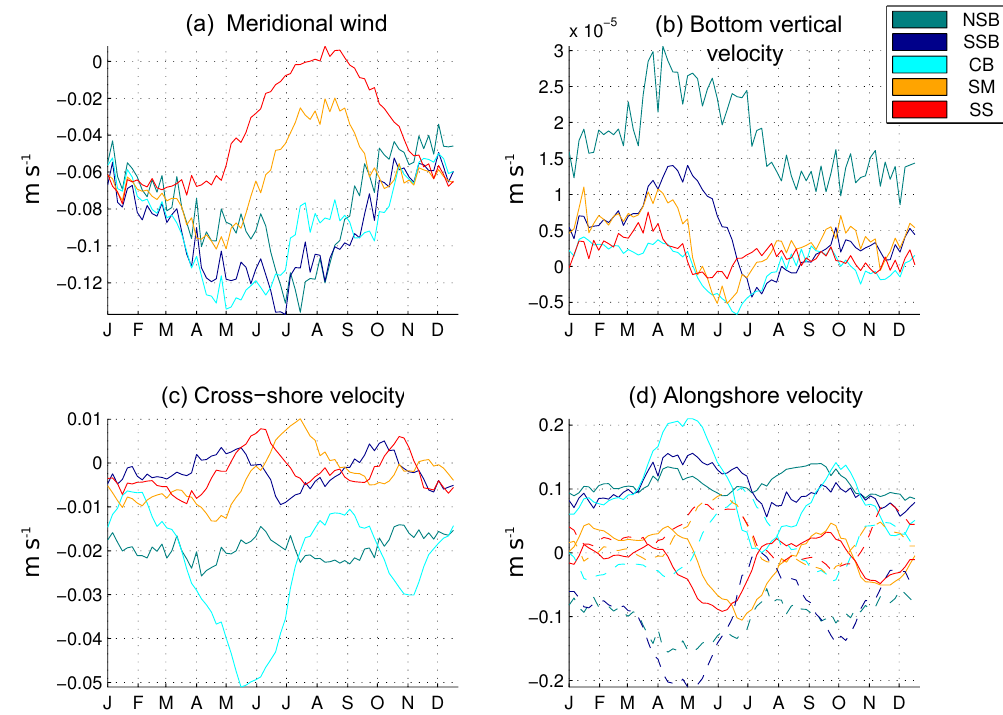
Figure 14. Seasonal climatology of (a) wind intensity (negative is upwelling-favourable, ms − 1 ) , (b) bottom vertical velocity (ms − 1 ) , (c) zonal velocities (ms − 1 ) and (d) meridional velocities (ms − 1 ) averaged within and over each edge of the coastal boxes (i.e. north, south, west and bottom; defined as positive inward and upward), respectively. In (d) , a solid (dashed) line represents a velocity at a northern (southern) edge of a box. Each colour corresponds to a box (see legends in Fig. 2 for coastal and Fig. 8 for offshore boxes): northern Saharan Bank (NSB), southern Saharan Bank (SSB), Cape Blanc area (CB), Senegalo-Mauritanian region (SM) and southern Senegal region